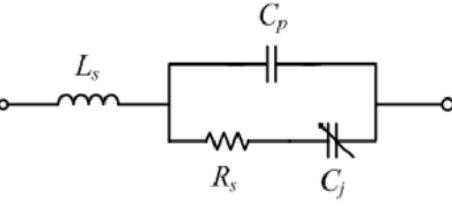
Figure 7. Gain and radiation efficiency of the proposed antenna with junction capacitance of 0.63 pF.